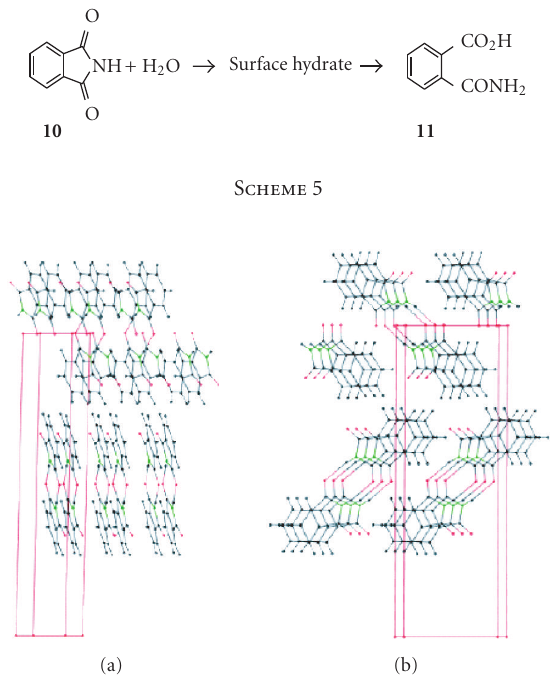
Figure 8: Crystal packing of phthalimide ( 10 ) including hydrogen bonds: (a) on (010); (b) on (101); both images are turned around y by 10 ◦ for a better view; the (001)-face is on top in both